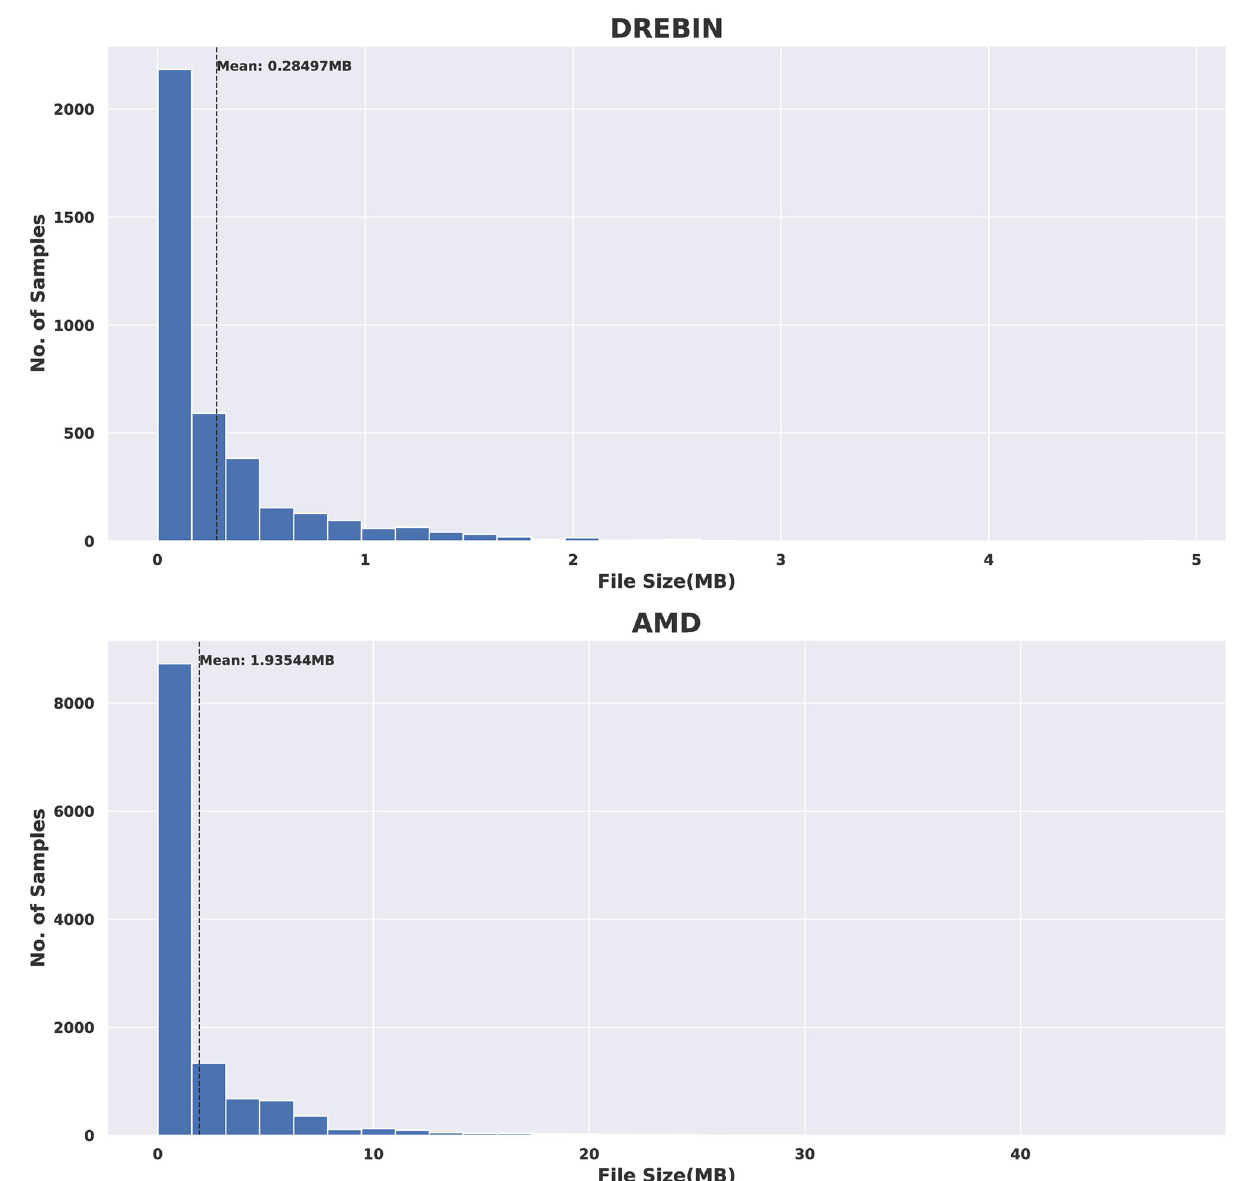
Fig 7. DREBIN VS AMD in terms of file size of APK